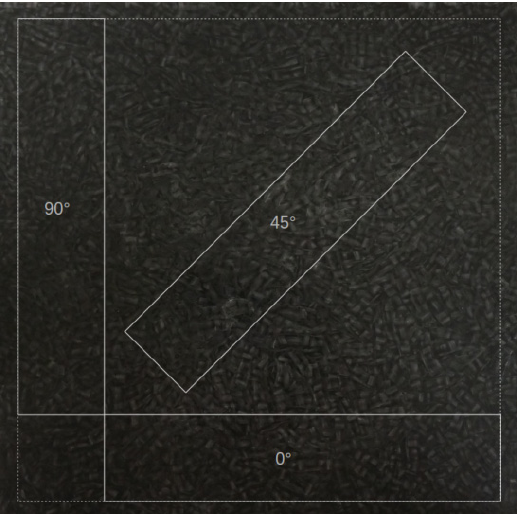
Figure 6. Specimen sampling at different orientations and different location of the panel.